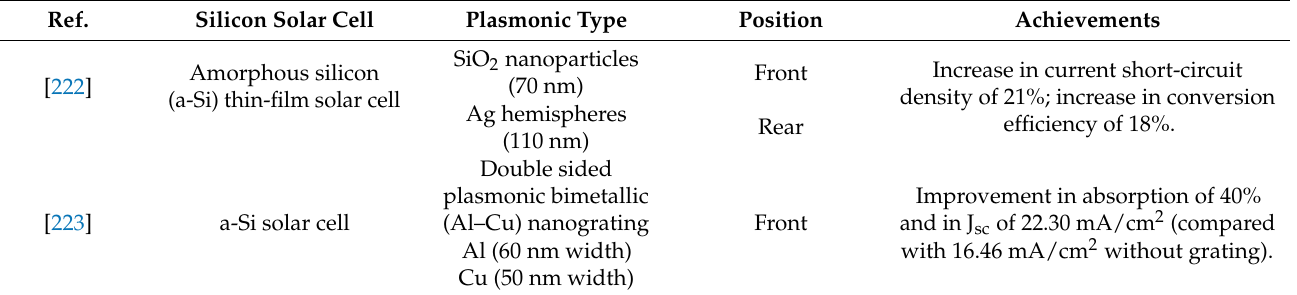
Table 3. Summary of research in which plasmonic nanoparticles were applied in silicon solar cells.